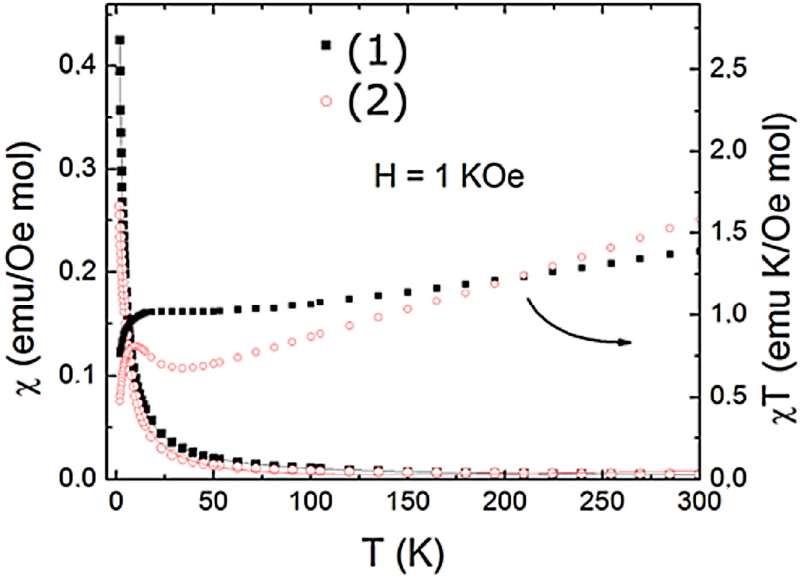
Figure 2. ( A ) UV-Vis spectra of the ligand (dashed black line), (1) (solid red line), and (2) (dotted blue line) in acetonitrile. ( B ) enlarged 450–850 cm − 1 absorption region. line) in acetonitrile. ( B ) enlarged 450–850 cm − 1 absorption region.